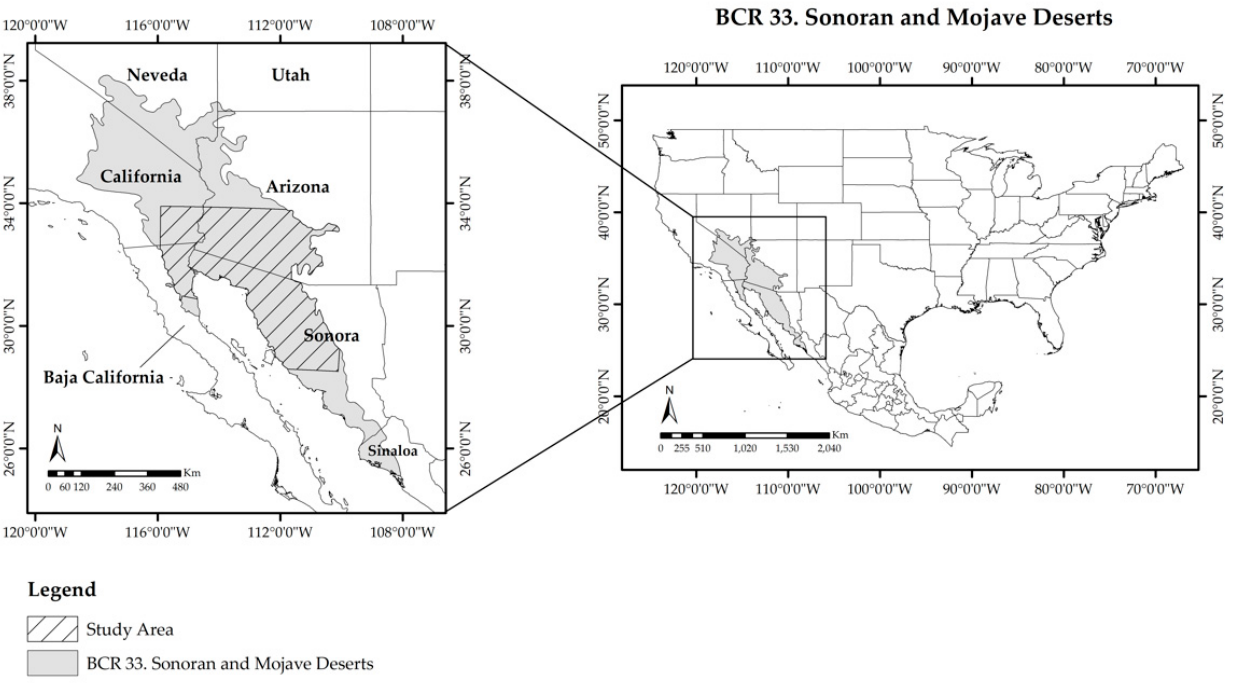
Figure 1. Bird Conservation Region 33. Sonoran and Mojave Deserts and the study area for this research from Phoenix, Arizona, US to Hermosillo, Sonora, MX.